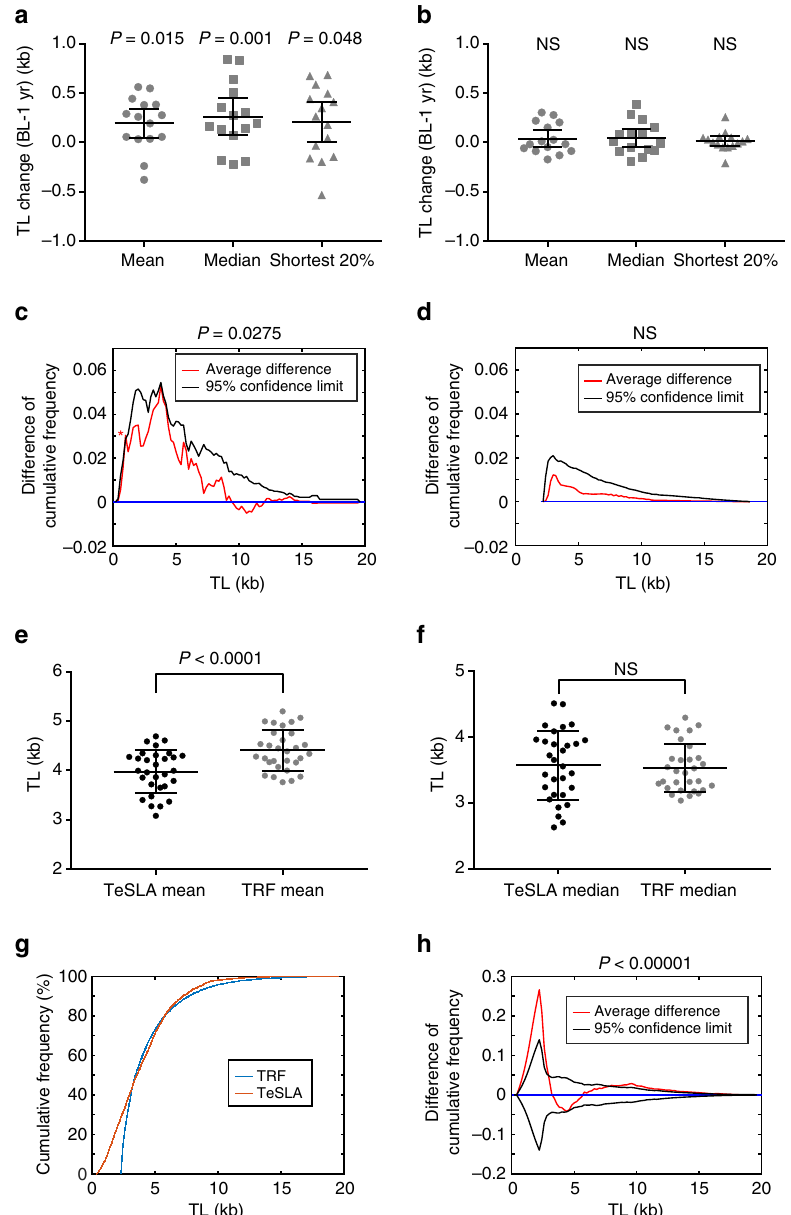
Fig. 6 TeSLA is sensitive enough to detect changes of TLs in a 1-year period of normal human aging. a , b Scatter dot blots comparing TLs in PBMCs measured at baseline and in 1-year period by TeSLA ( a ) and TRF analysis ( b ). The mean, the median, and the shortest 20% TLs of 15 normal healthy subjects (age from 51 to 69) were averaged. P -values from paired t -tests are shown as indicated above. BL, baseline; 1 yr, one year after; NS, not signi fi cant. c , d The average changes of TL distributions in PBMCs in a 1-year period of 15 subjects measured by TeSLA ( c ) and TRF analysis ( d ). One-year differences in cumulative frequencies from each subject were computed (see Supplementary Fig. 5e, f as examples). The average of 1-year changes in TL distributions of 15 subjects is shown in red, and one-sided 95% con fi dence limit (black) is derived from permutation. The asterisk represents the value (~1 kb of TL) that lies outside the 95% con fi dence limit, which indicates the most signi fi cant effect on telomere shortening. e , f Scatter plots comparing TeSLA and TRF analysis for mean ( e ) and median ( f ) TL measurements ( n = 30) in PBMCs. g Comparison of TeSLA and TRF analysis of empirical distribution curves of pooled TLs from all 30 DNA samples. h The averaged differences (red) in cumulative frequencies (TeSLA-TRF) by the same method used in c and d show large difference between TeSLA and TRF in the short TL analyses (0.6 – 2.8 kb). Black lines are 95% con fi dence limits obtained from permutation. ( a , b ; mean and s.e.m., n = 15) ( e , f ; mean and s.e.m., n =